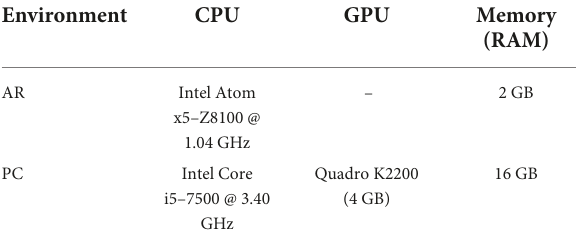
TABLE 1 Hardware parameters of HoloLens and personal computer